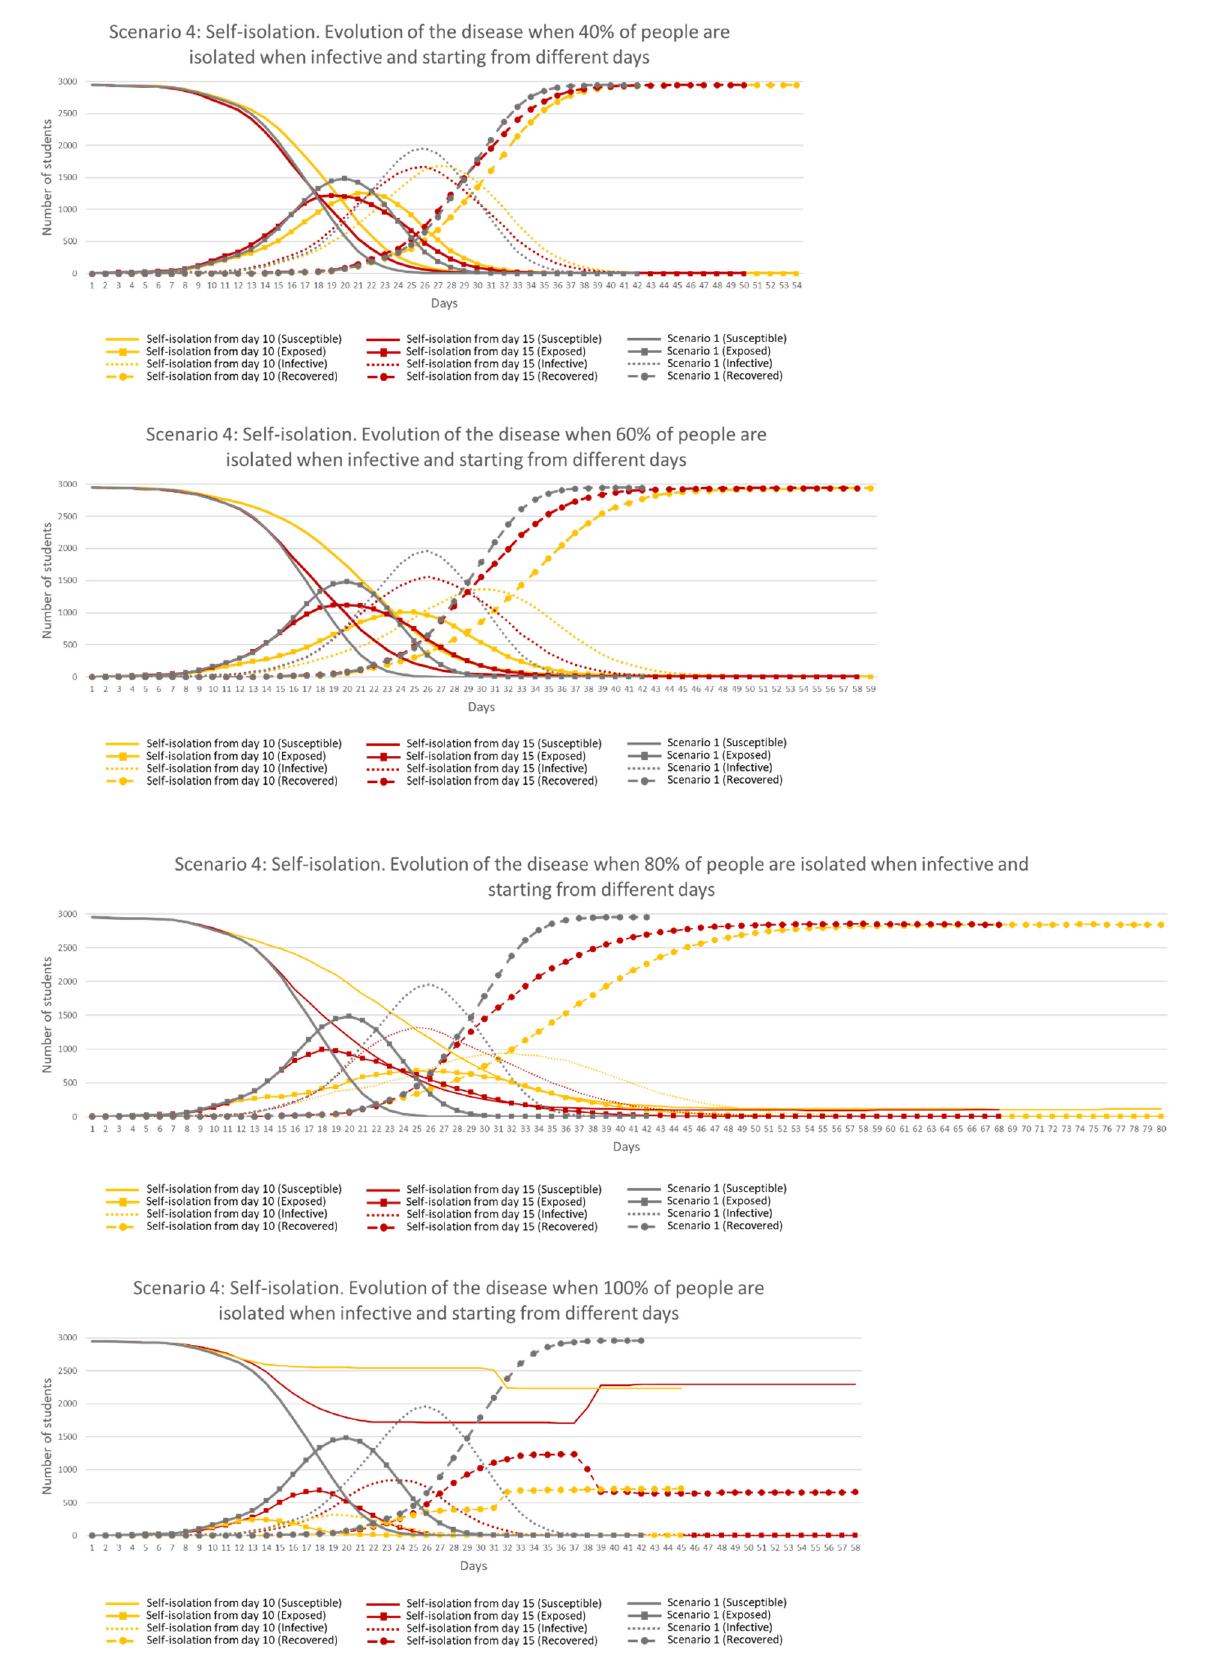
Figure A3. Comparison of the evolution of the disease between Scenarios 4 (Self-Isolation) against Scenario 1 (No Measures).